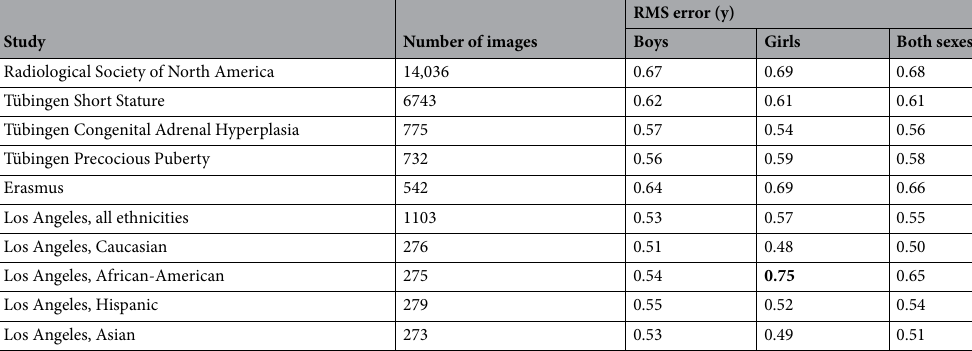
Table 1. Accuracy of the BoneXpert bone age method on six studies. The table presents RMS errors obtained when training on these data; cross-validated RMS errors are 0.01 y higher (see supplementary material). The accuracy in the Los Angeles study is also subdivided into the four ethnicities, and the accuracy is significantly worse in African American girls: It is 0.75 y with a 95% confidence interval of [0.65; 0.85]